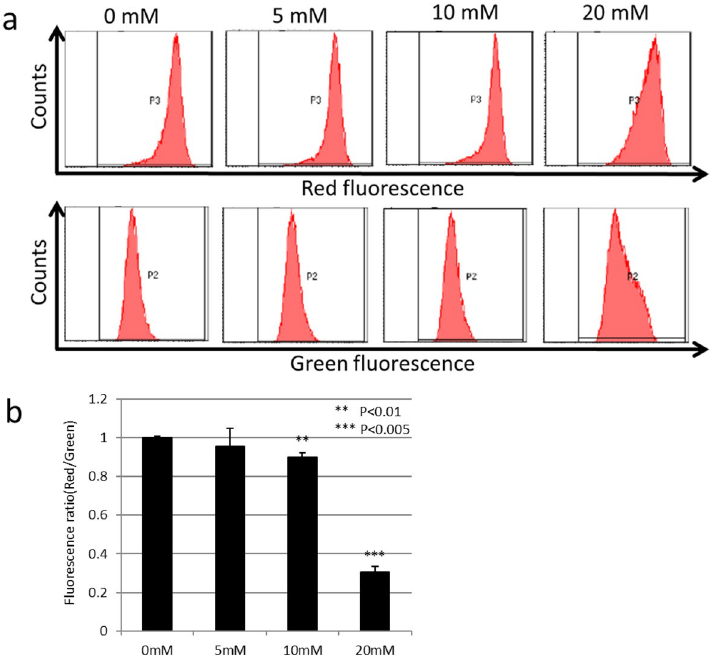
Figure 5. Mitochondrial injury induced by synthesized 2,3-dimethyltartrate. ( a ) Mitochondrial injury induced by 5, 10, or 20 mM of synthesized 2,3-dimethyltartrate. U251SP glioblastoma cells were stained with the JC-1 probe, and red and green fluorescence were measured by the flow cytometry. ( b ) Fluorescence intensities were measured, and red/green fluorescence ratios were calculated. Values are presented as mean ± SD (n =